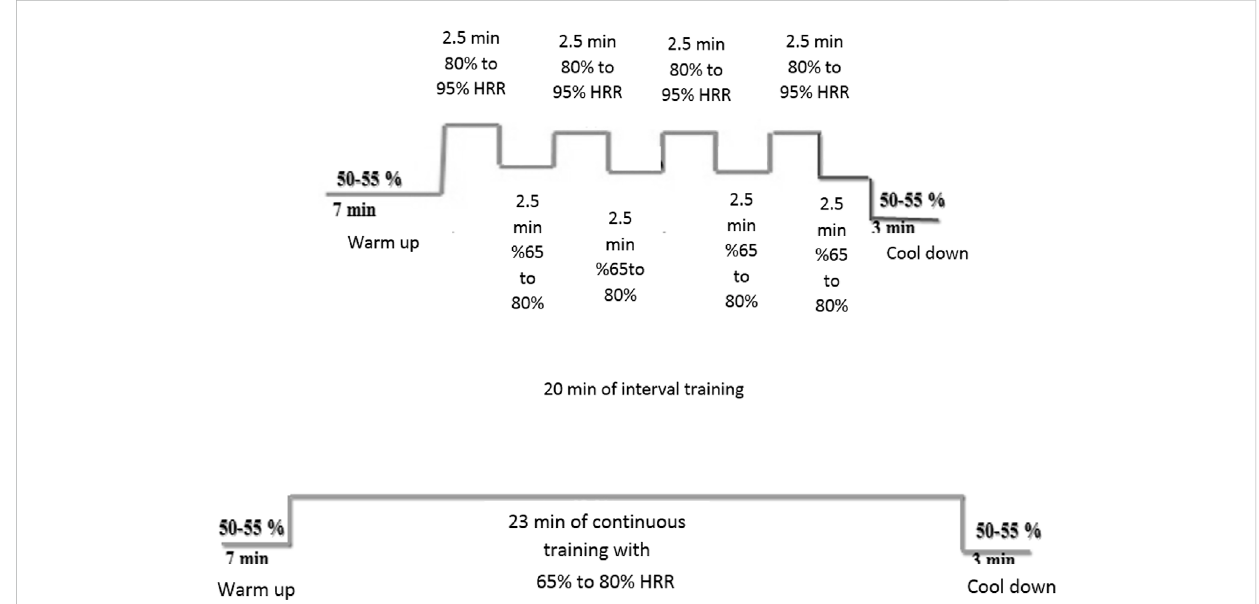
FIGURE 2 High Intensity Interval Training (HIIT) and Moderate Continuous Training (MCT) protocols.